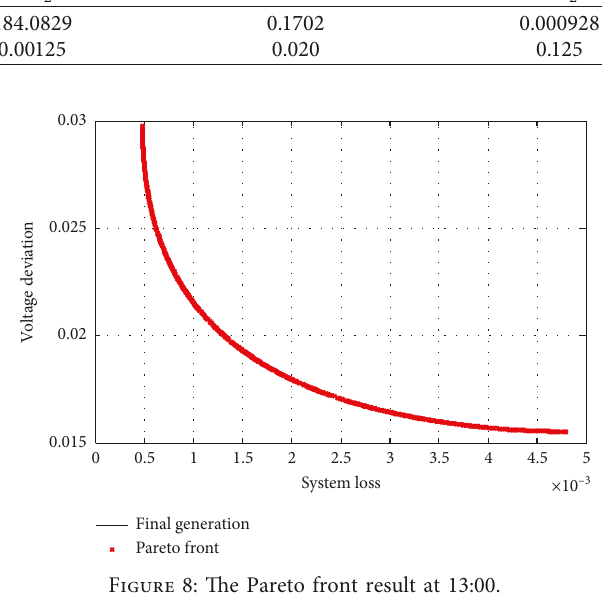
Figure 8: The Pareto front result at 13:00.